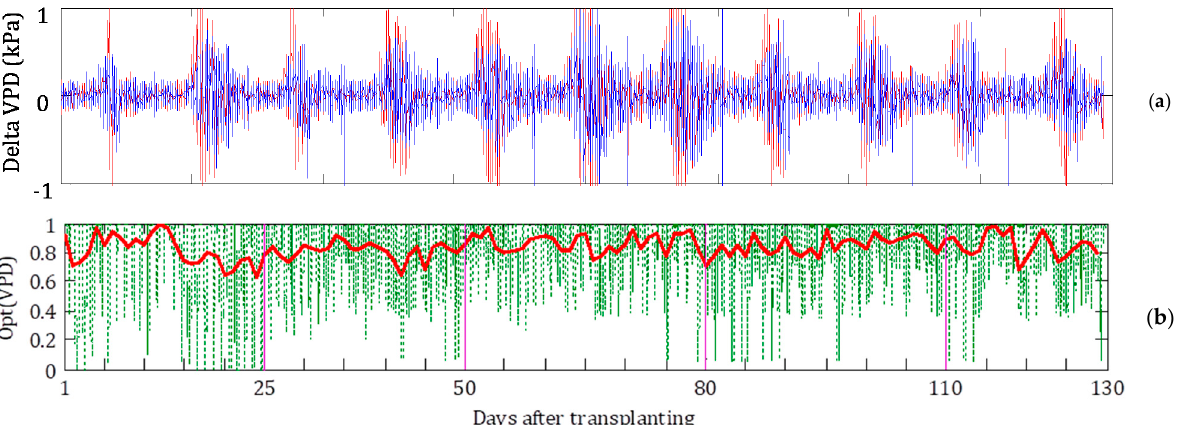
Figure 15. Variation in the VPD data ( a ), and optimality degree of VPD ( b ) resulting from the air temperature and relative humidity data of the proposed M-DAC system simulated for greenhouse cultivation of tomato in 130 days.